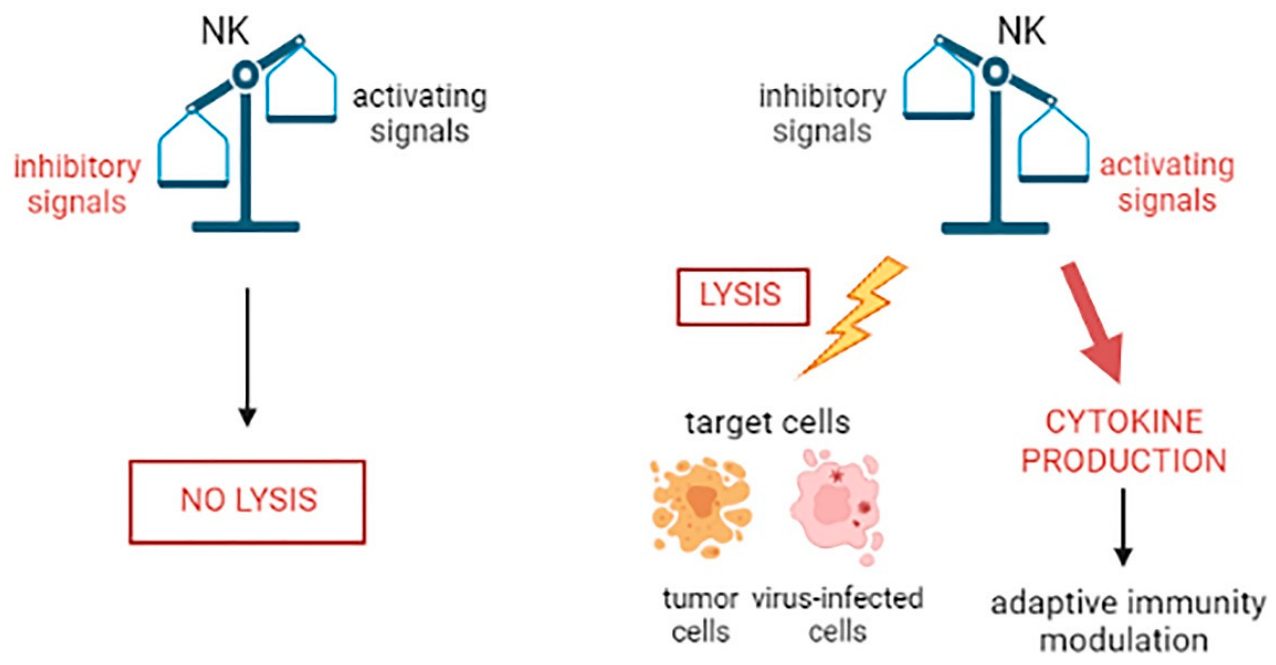
Figure 2. NK cells effector functions regulation by activating and inhibitory signals combination. Depending on the prevalence of inhibitory or activating environmental signals, NK cells can be respectively inhibited or stimulated to lyse target cells (tumor or infected) or to produce cytokine.